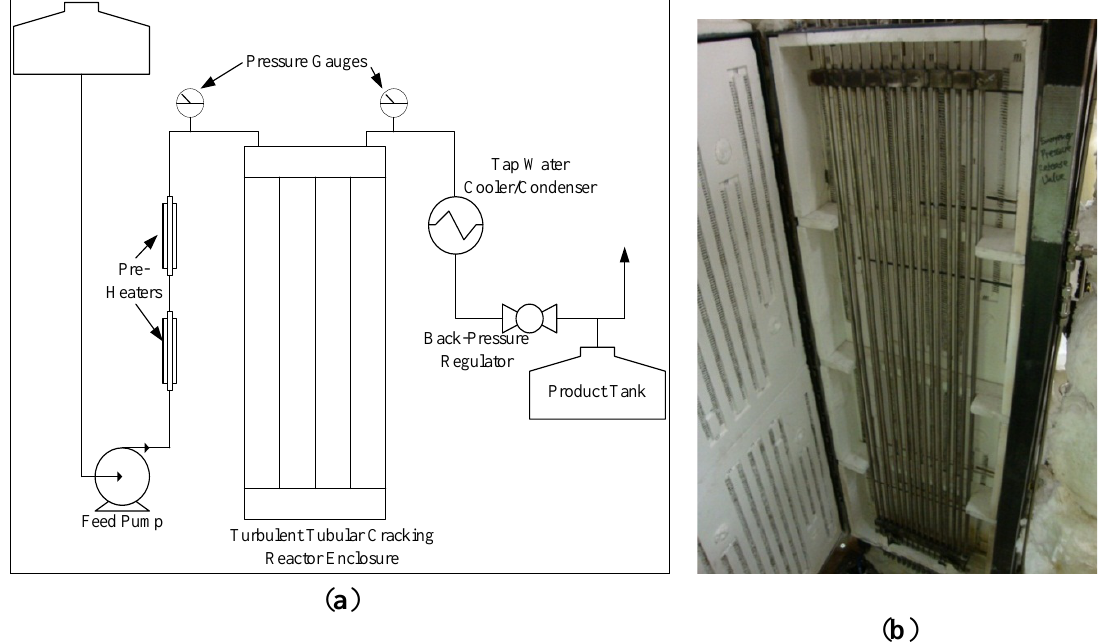
Figure 2. Diagram ( a ) and photo ( b ) of the University of North Dakota’s pilot scale continuous tubular non-catalytic cracking